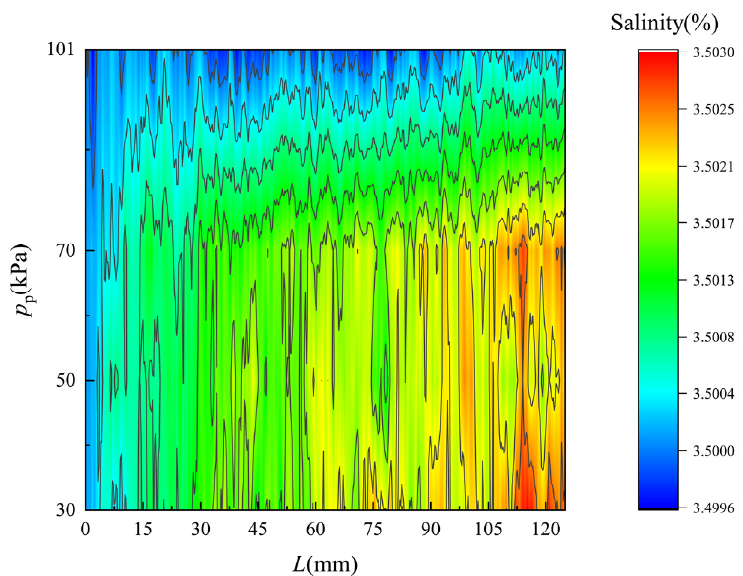
Figure 10. Salinity distribution of flow along the feed side of the membrane surface. T f = 318 K.